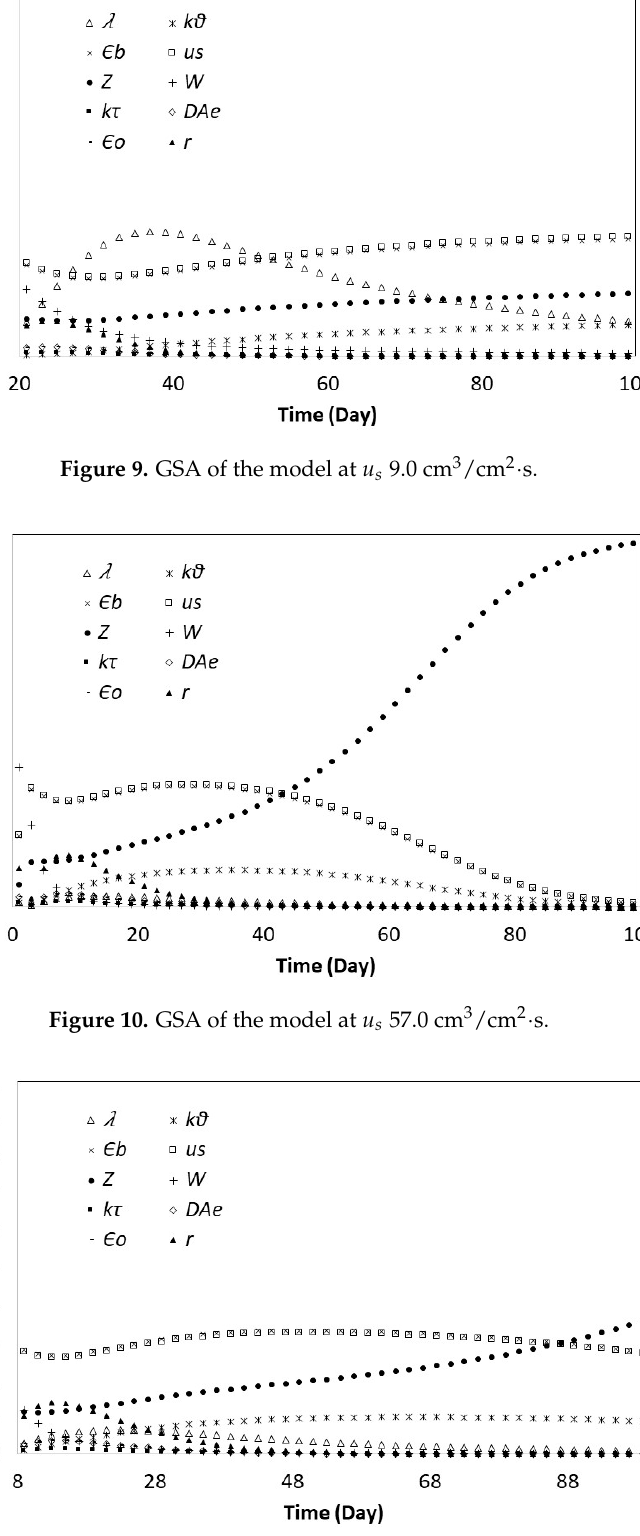
Figure 11. GSA of the model at D Ae 0.06 cm 3 /cm 2 · Figure 11. GSA of the model at (cid:1830) (cid:3002)(cid:3032) 0.06 cm 3 /cm 2 d. Figure 11. GSA of the model at (cid:1830) (cid:3002)(cid:3032) 0.06 cm 3 /cm 2 d.